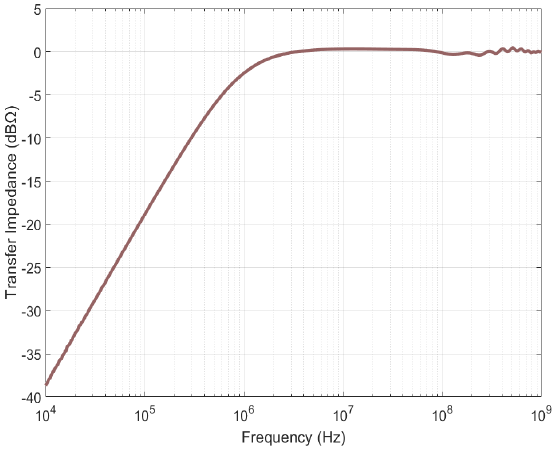
Figure 7. Transfer impedance magnitude of the F-65 current monitor probe.